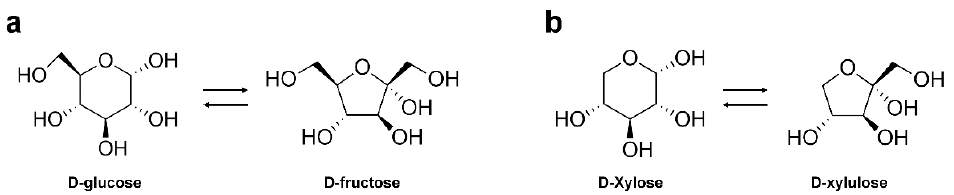
Figure 1. Catalytic reaction of glucose isomerase. Reversible isomerization between ( a ) D ‐ glucose and D ‐ fructose, and ( b ) D ‐ xylose and D ‐